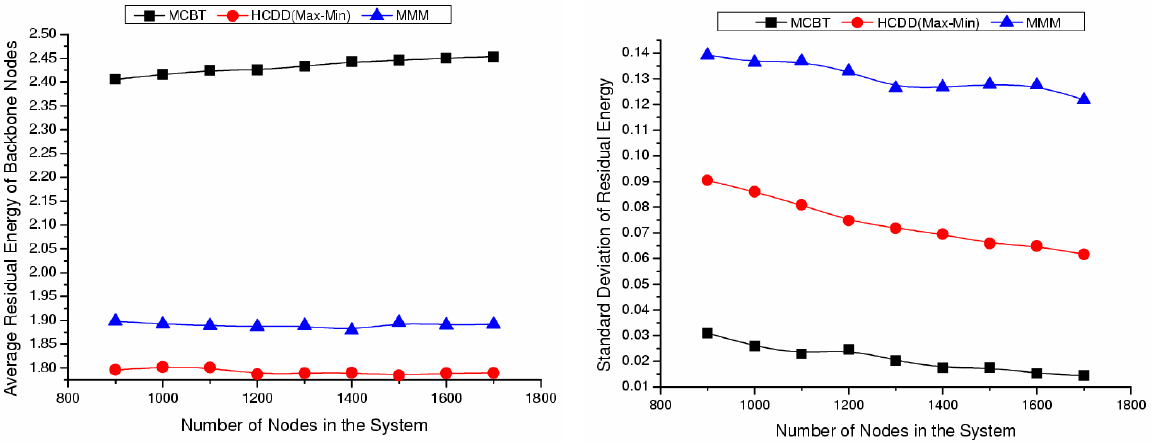
Figure 6. Residual energy of backbone nodes.